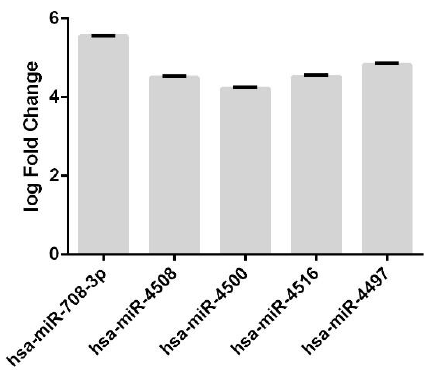
level of each miRNA (rows) was averaged within the pre-classified group (column). Values are ex- pressed as log2CPM.